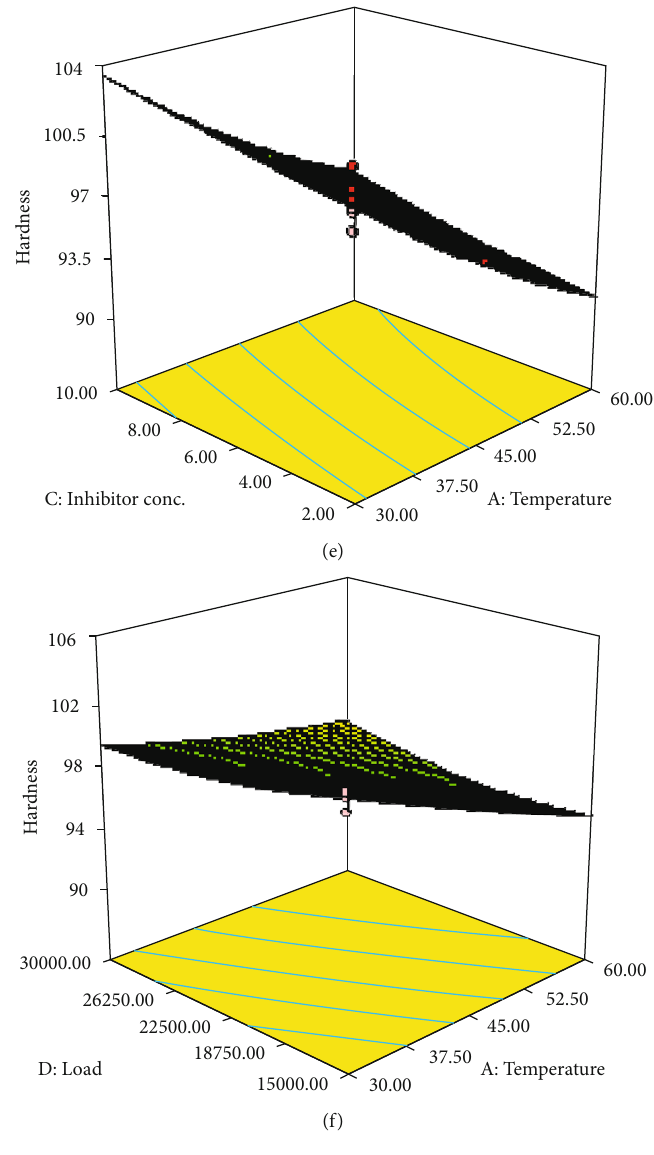
Figure 10: 3D response surface plot showing (a) inhibitor concentration and immersion time, (b) load and immersion time, (c) load and inhibitor concentration, (d) immersion time and temperature, (e) inhibitor concentration and temperature, and (f) load and temperature in fl uence on Table 10: Optimum point prediction by Box-Behnken Design and experimental result at optimum predicted point. Parameter